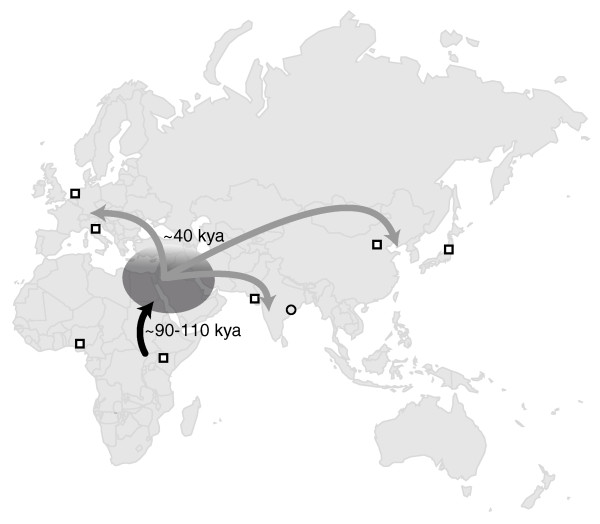
The 'delayed expansion' hypothesis. In this hypothesis, the ancestal Eurasian population separated from African populations approximately 100 kya but did not expand into most of Eurasia until approximately 40 kya.